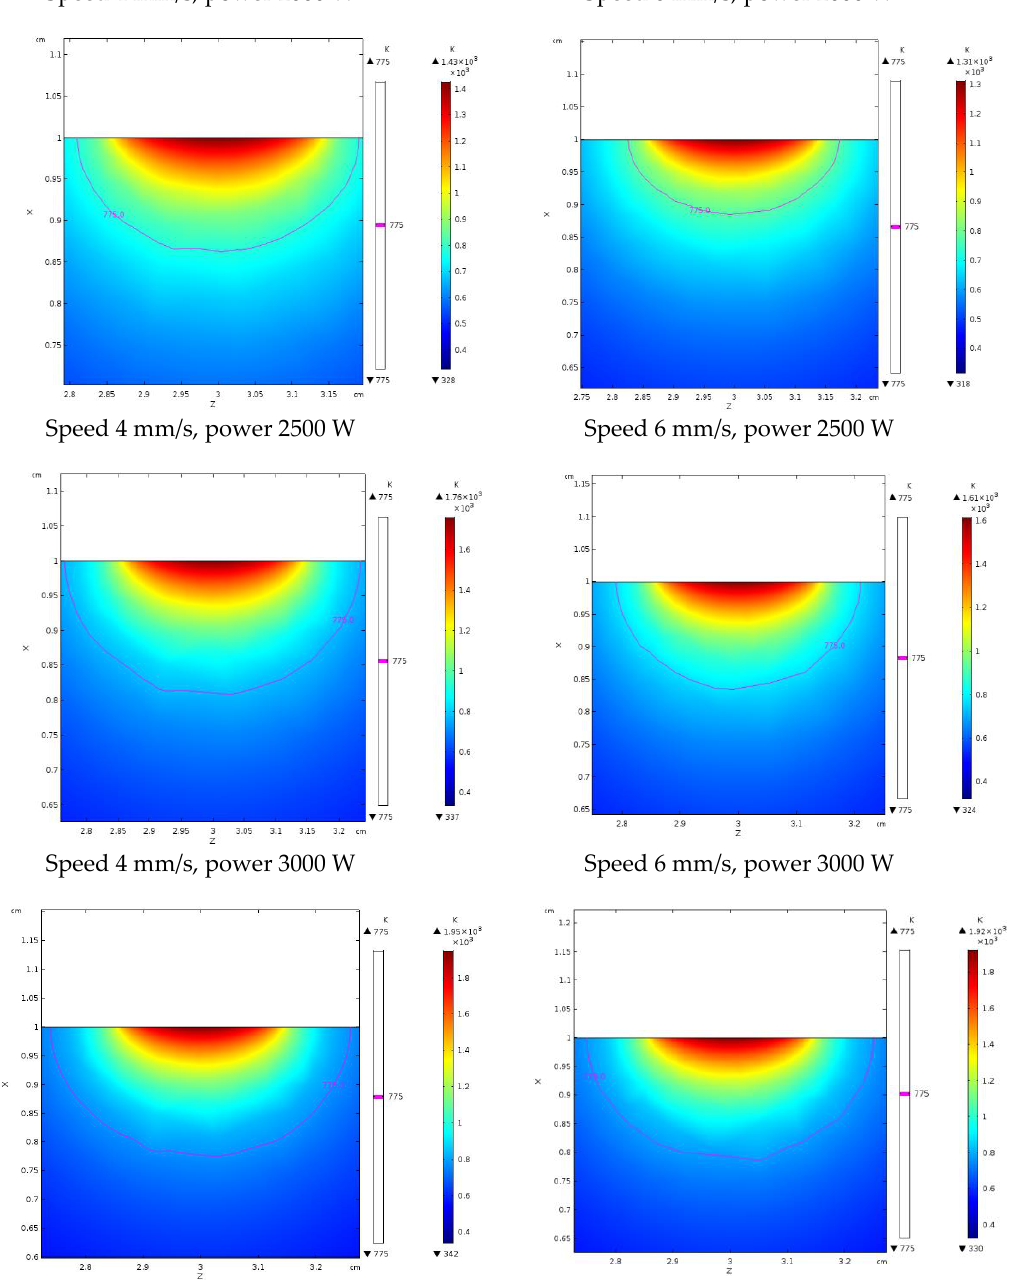
Figure 11. Contour lines to define the extent of the fusion zone for each processing condition.